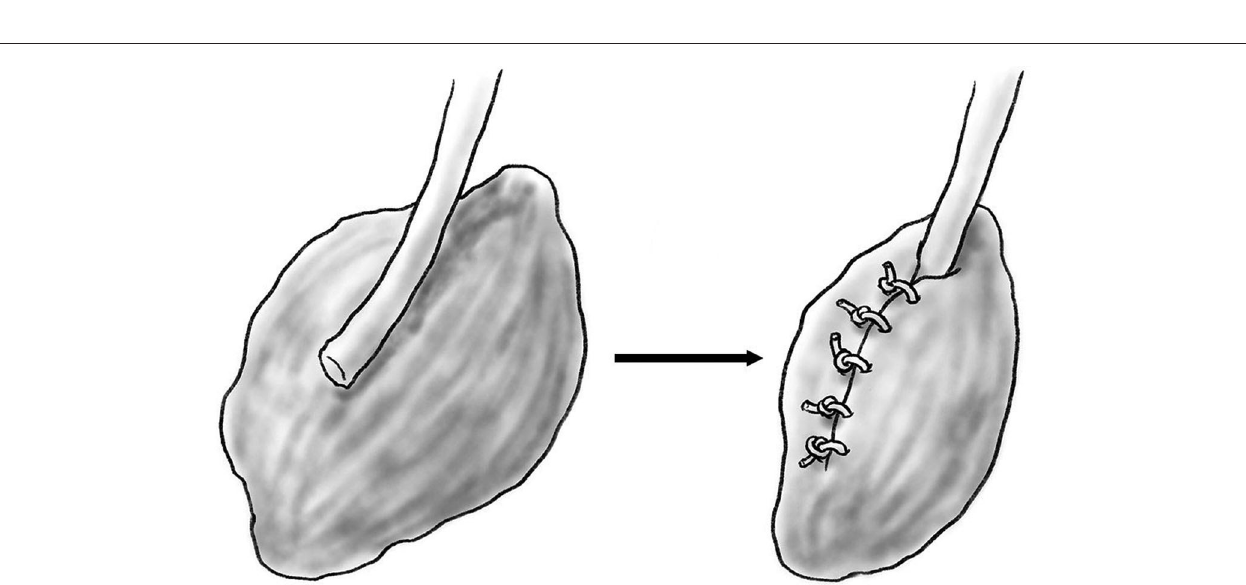
FIGURE 6 | Diagram of transected peripheral nerve wrapped with free denervated muscle